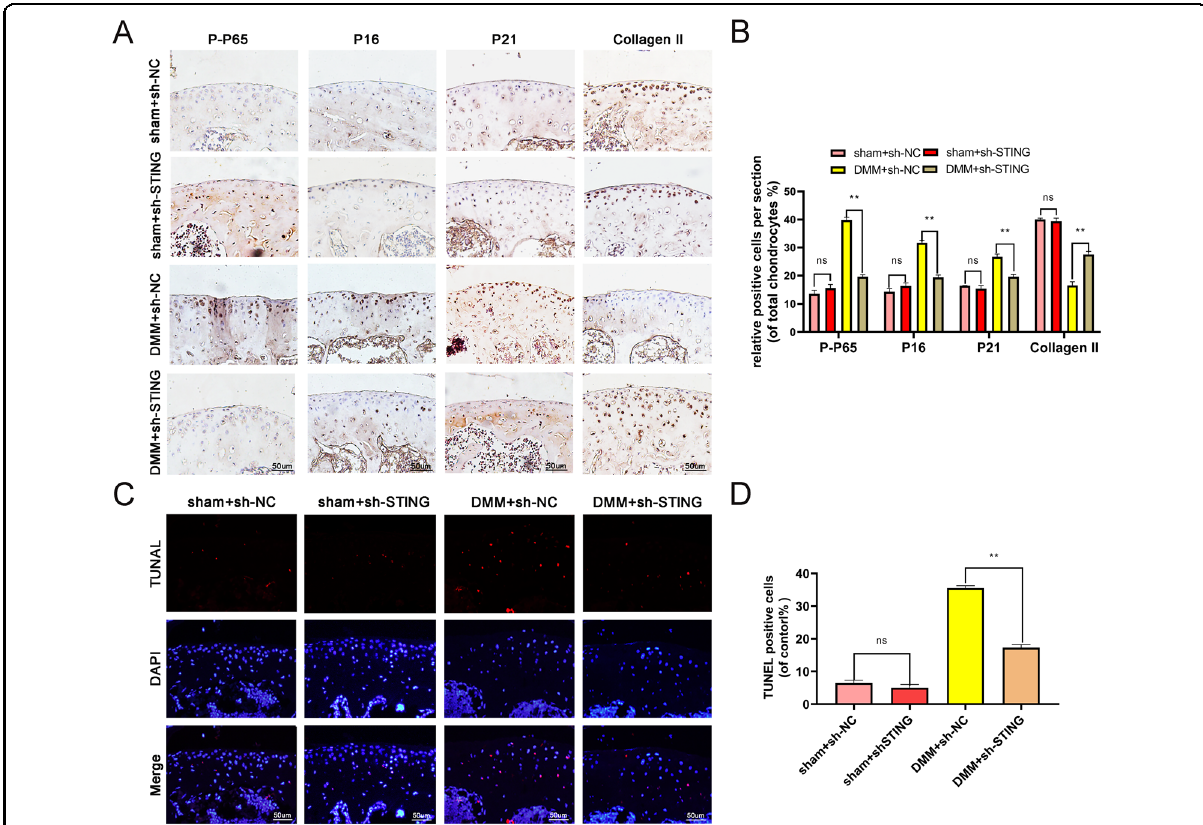
Fig. 7 STING knockdown ameliorates the degradation of the ECM, senescence, and apoptosis by inhibiting NF- κ B in vivo. A – B The expression of p-P65, p16INK4a, P21, and collagen II were evaluated by immunohistochemistry in mouse cartilage (bar: 50 μ m). C – D TUNEL staining assay in mouse cartilage (bar: 50 μ m). All data were presented as mean ± SD ( n = 15); ** P <